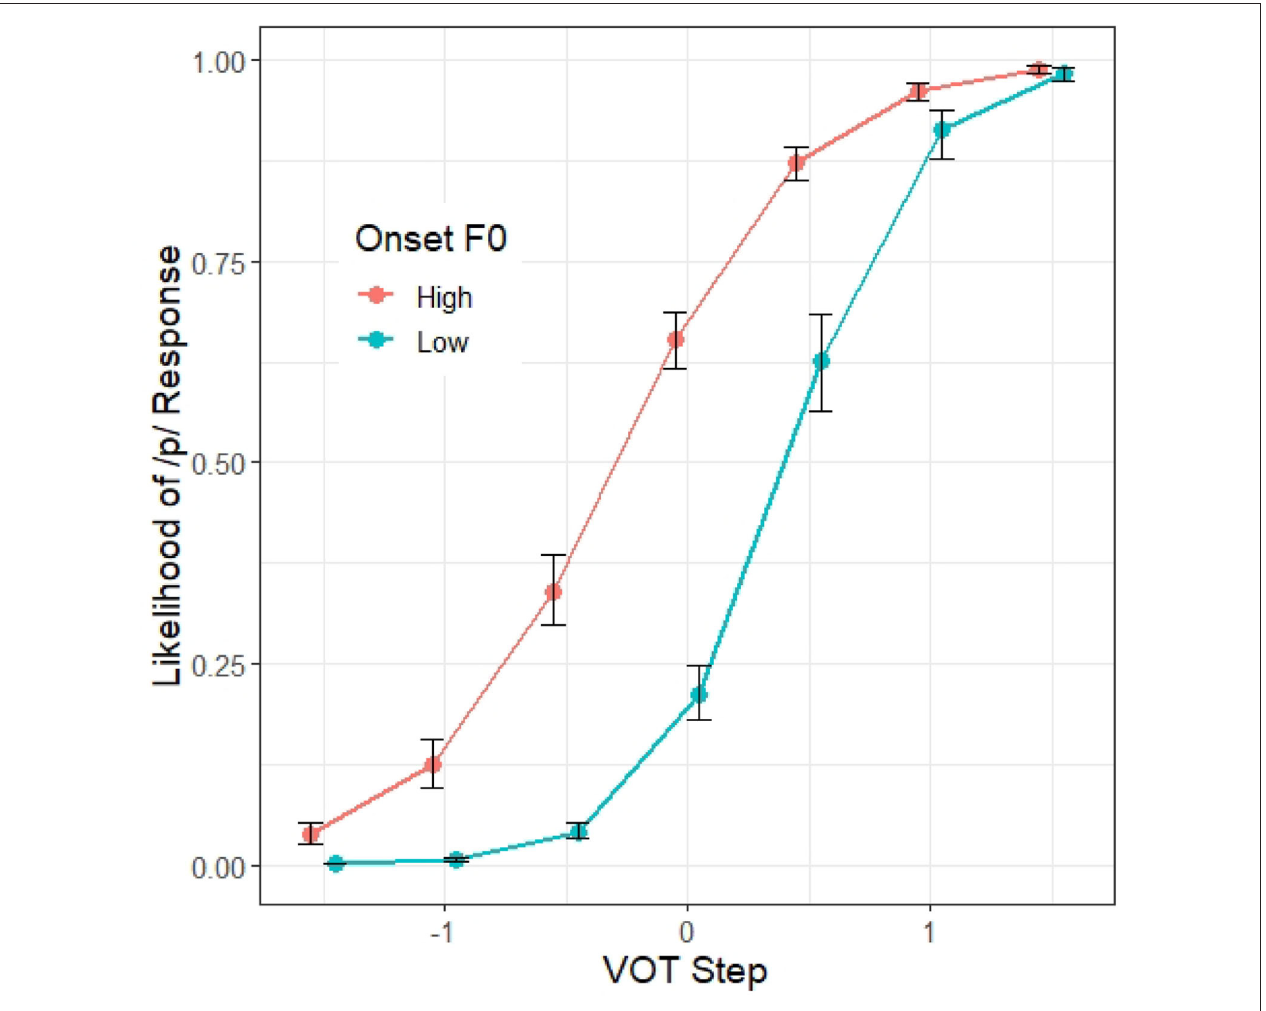
FIGURE 2 | Model 1 predictions of the probability of a /p/ response (y axis) at different steps on the VOT continuum (x axis) and F0 targets. The error bars indicate 95% confidence